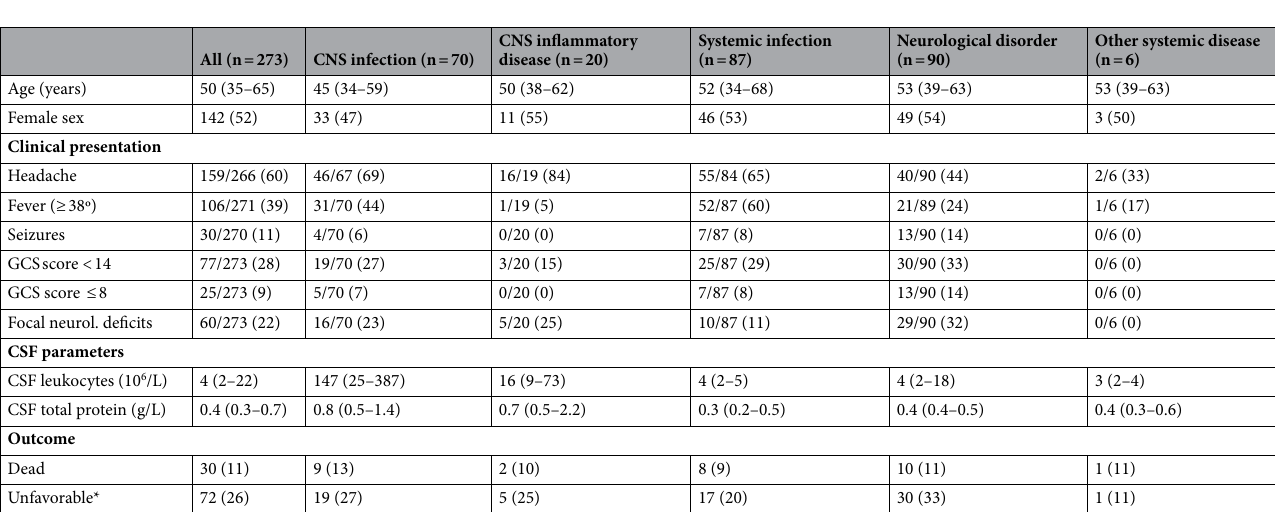
Figure 1. Inclusion flow chart.